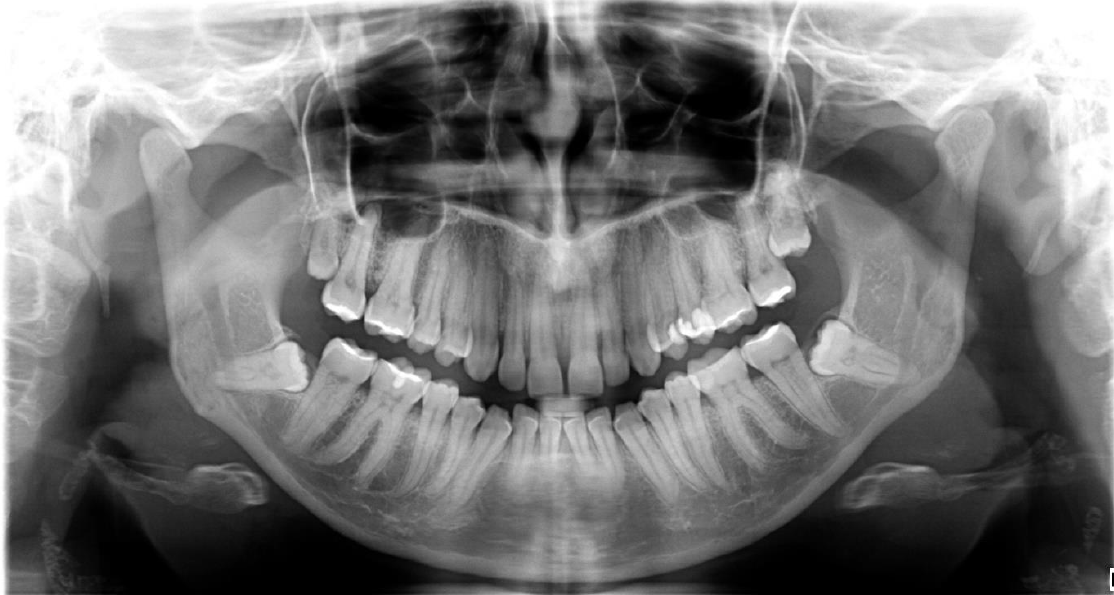
Figure 1. Impaction of four third molars on orthopantomogram (OPG). Table 2. Proportion of different tooth types (according to the Viohl system) in study group pa- tients.